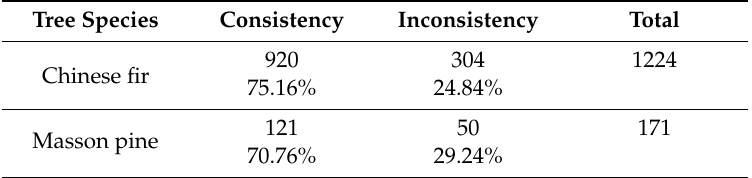
Table 11. Results of rule